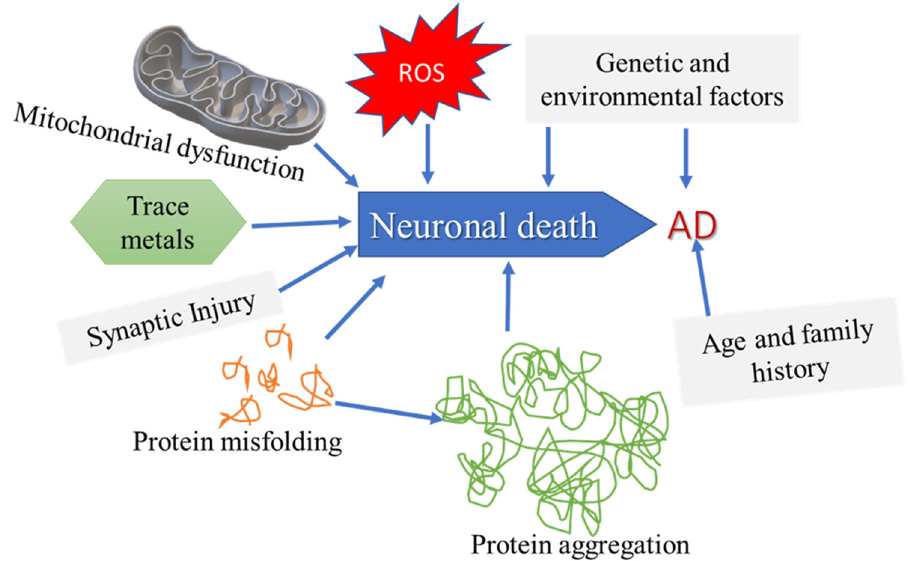
Figure 1. Common etiological factors that might lead to neurodegeneration. The etiological origins of neurodegenerative diseases such as AD are unknown, but the known stimulators are multifactorial, i.e., genetic, environmental, aging, and molecular. AD displays the typical characteristics associated with neurodegeneration: protein misfolding provoking protein aggregation, synaptic dysfunction, metal toxicity, mitochondrial dysfunction, and